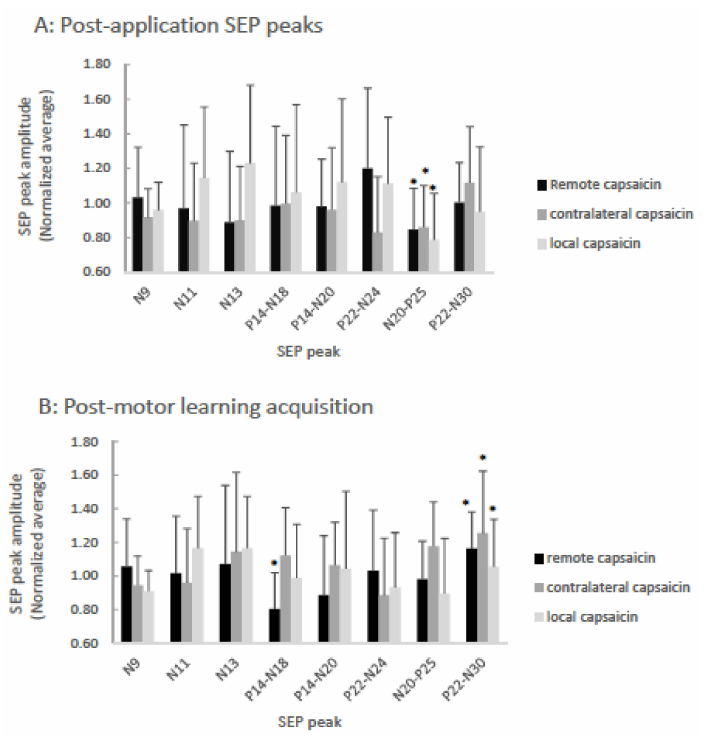
Figure 3. Bar-graph of averaged normalized (to pre-motor learning values) SEP ratios showing capsaicin versus remote versus contralateral groups post-application ( A ), and post-motor learning acquisition ( B ). A: The P25 ( p < 0.001) SEP peaks significantly decreased following the application of capsaicin cream for all groups as indicated by asterisks. B: Following motor learning acquisition, significantly different changes from baseline are indicated by asterisks for the remote group N18 SEP peak ( p = 0.02) and for all three groups the N30 ( p = 0.002) SEP peaks were significantly increased. Error bars represent the standard